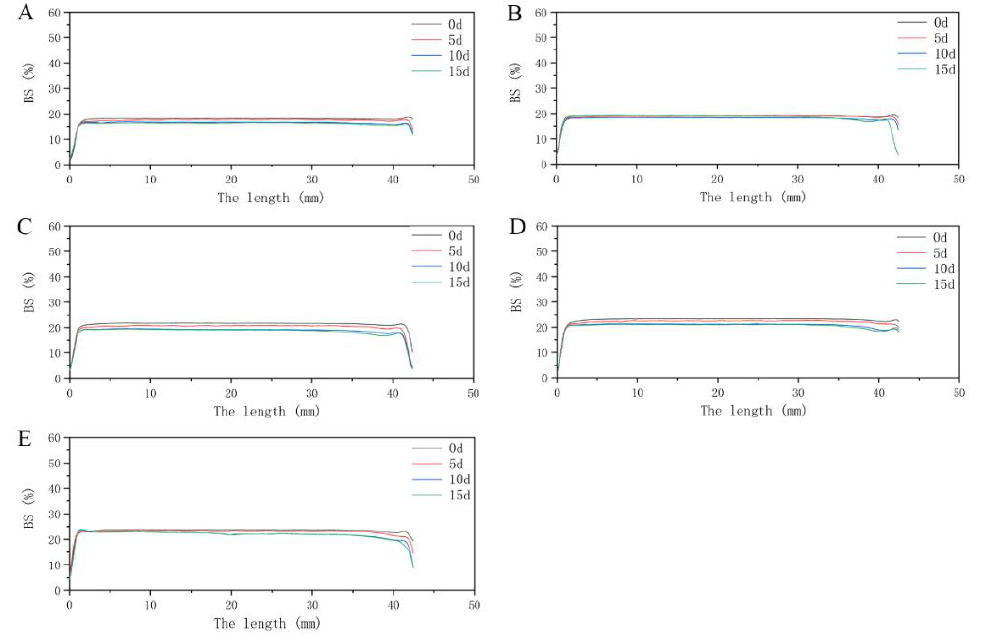
Figure 4. Back scattering (BS) of FVP–WPI solutions over storage time under static conditions. ( A ) 0.4% FVP–3% WPI solution; ( B ) 0.4% FVP–4% WPI solution; ( C ) 0.4% FVP–5% WPI solution; ( D ) 0.4% FVP–6% WPI solution; ( E ) 0.4% FVP–7% WPI solution.